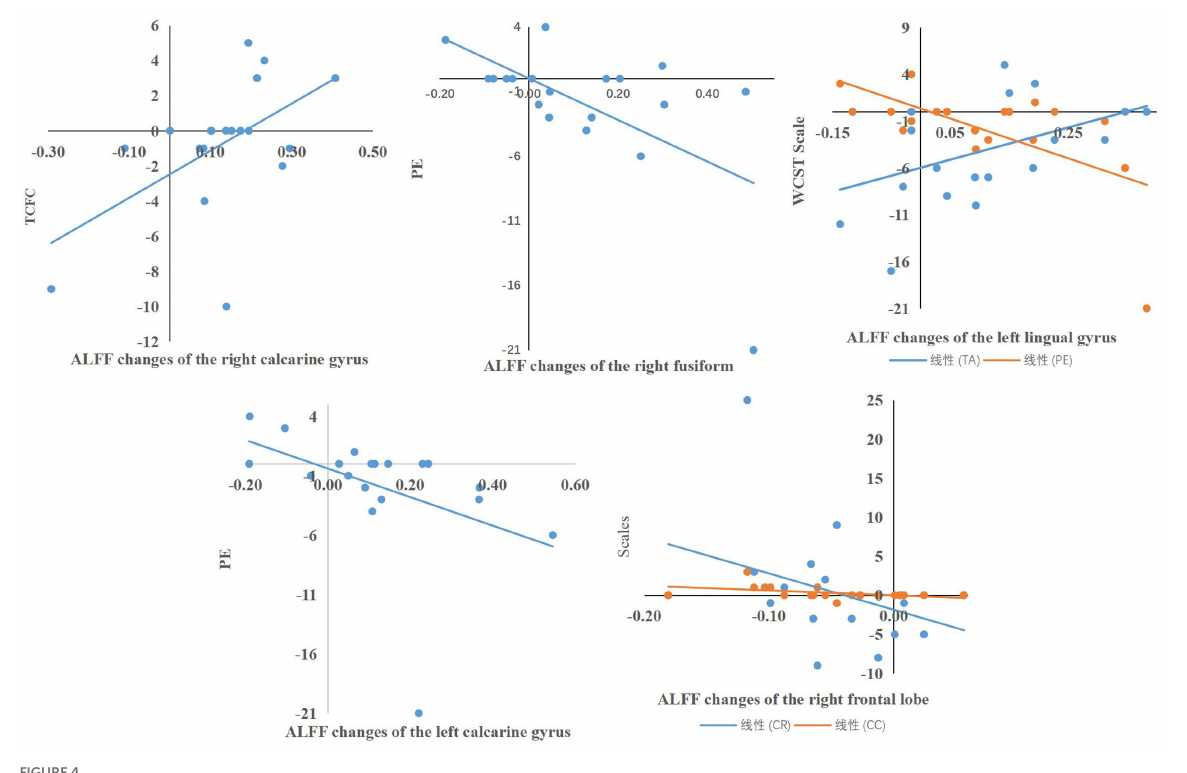
FIGURE 4 Correlation between the variability of ALFF and the variability of WCST task performance.